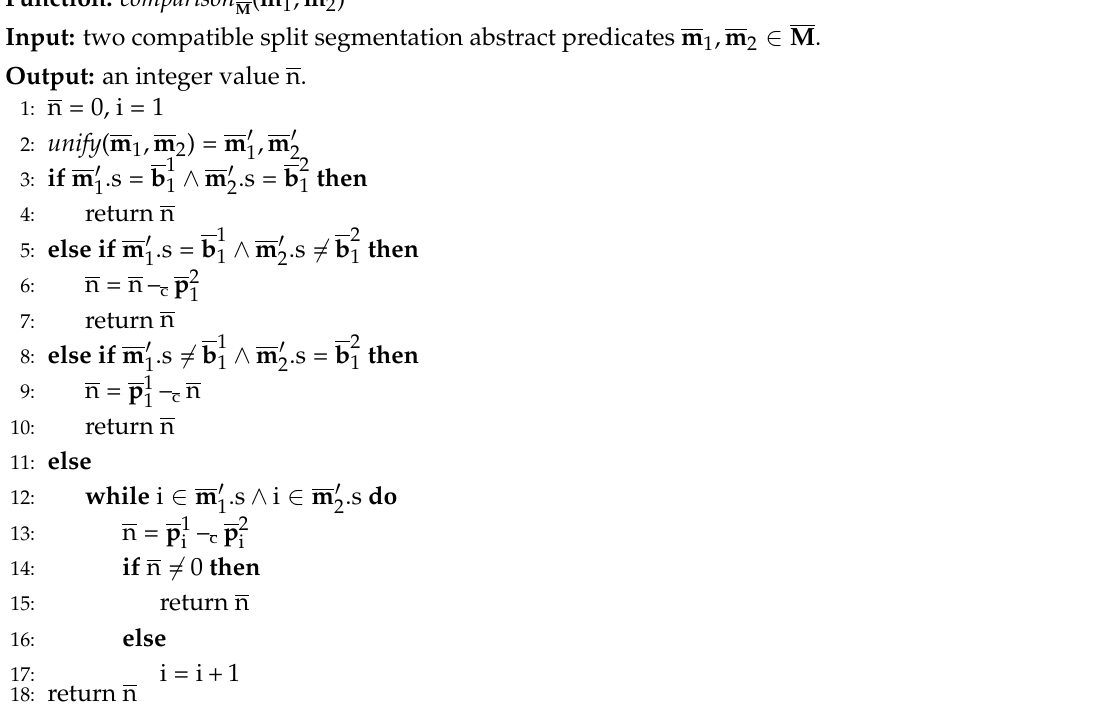
Algorithm 2 Lexicographic comparison of split segmentation abstract